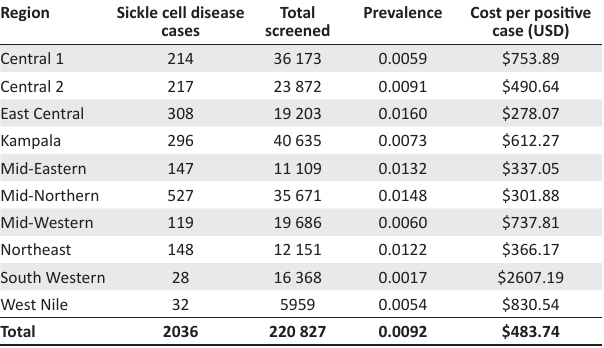
TABLE 6: Cost per positive sickle cell disease case in Uganda, by region from February 2014 to March 2019. Region Sickle cell disease cases